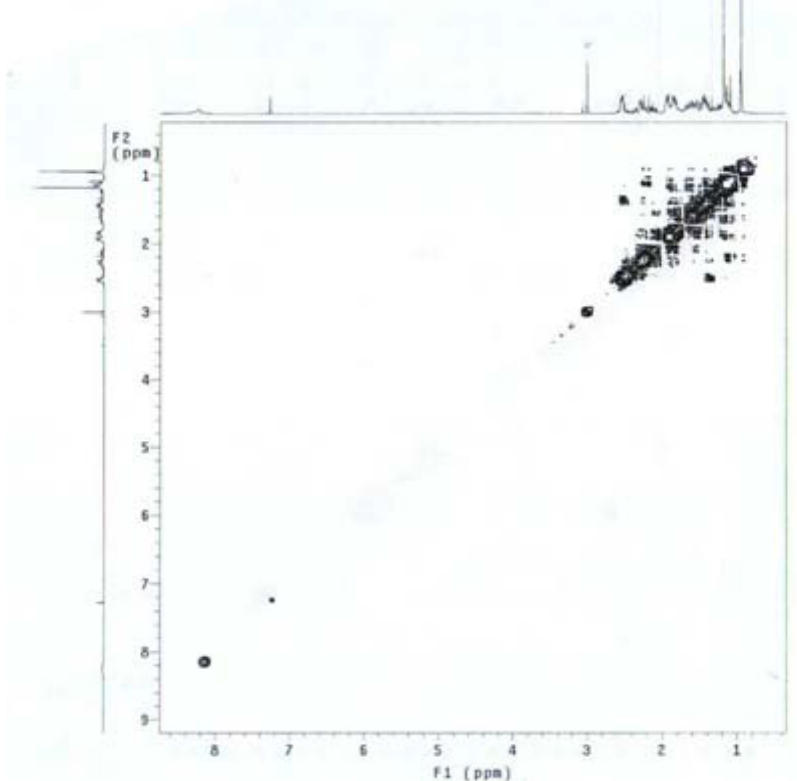
Figure 5. 1 H- 1 H COSY spectrum of 11